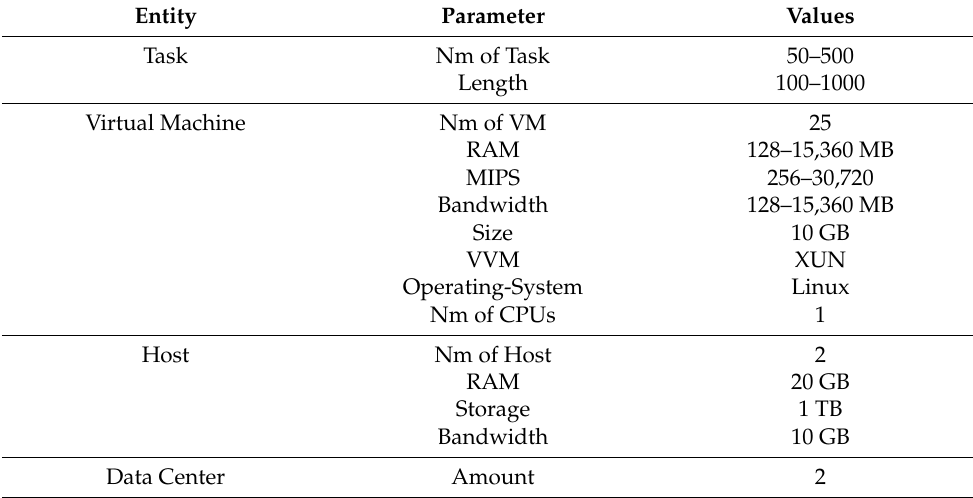
Table 5. Environment 2